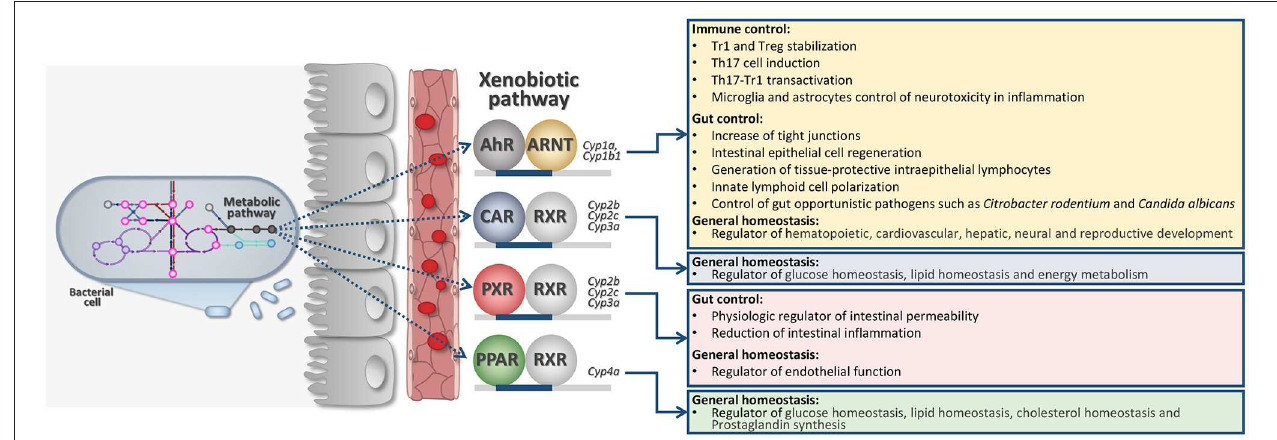
FIGURE 1 | Intricate microbiota-derived metabolic pathways may affect host XR activation and general host physiology. AhR, Aryl hydrocarbon receptor; ARNT, Aryl Hydrocarbon Receptor Nuclear Translocator; CAR, Constitutive Androstane Receptor; RXR, Retinoid X Receptor; PXR, Pregnane X Receptor; PPAR, Peroxisome Proliferator-Activated